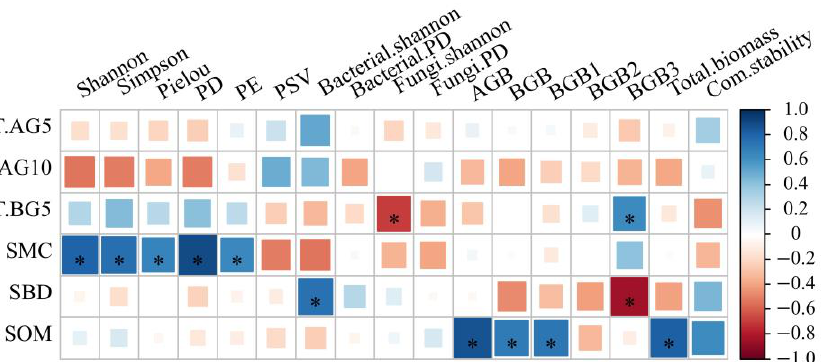
Figure 6. Correlation of environmental factors with biodiversity and ecosystem function. * indicates the significance of correlation ( p = 0.05); T.AG5, T.AG10, T.BG5, SMC, SBD and SOM indicate temperature at 5 cm above ground, temperature at 10 cm above ground, temperature at 5 cm in soil, soil moisture content, soil bulk density and soil organic matter, respectively; PD, PE and PSV indicate phylogenetic diversity, phylogenetic endemism and phylogenetic species variability, respectively; AGB and BGB denote aboveground biomass and belowground biomass; BGB1, BGB2 and BGB3 denote belowground biomass at 0–10 cm, 10–20 cm and 20–30 cm, respectively.